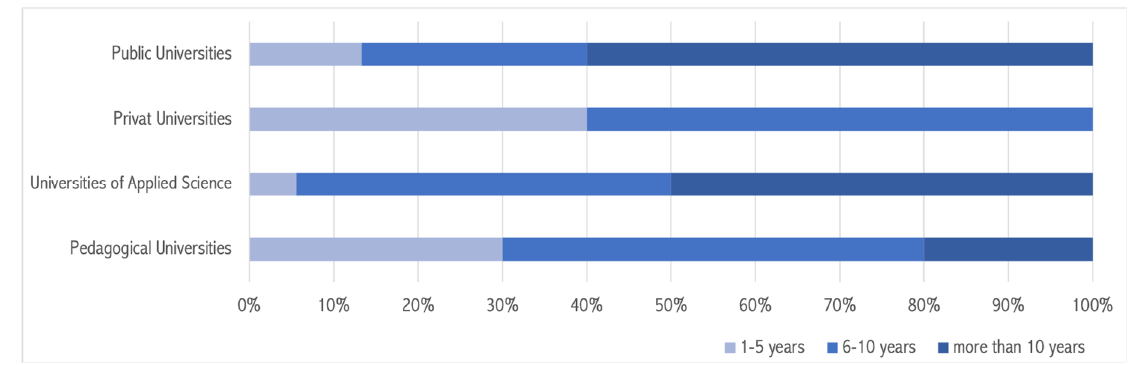
Figure 1. Experiences with e-learning in years per type of university in Austria. Source: Own diagram, using data by Bratengeyer et al., 2016 [15], taken from p. 40, Figure 6.